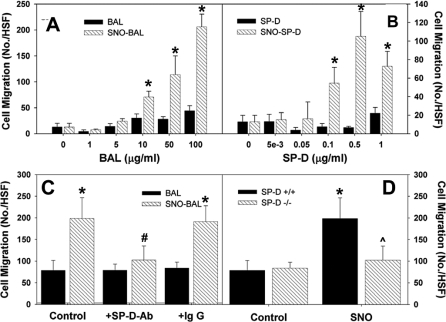
SNO-SP-D Induces Macrophage Chemotaxis(A and B) BAL and recombinant SP-D were assessed for their ability to induce RAW 264.7 macrophage migration using a modified Boydin chamber, following treatment with 200 μM SNOC or cysteine.(C) Using a BAL does of 100 μg/ml, cell migration was assayed subsequent to treatment with anti-SP-D or non-immune IgG.(D) SNOC treatment of BAL from SP-D
–/– mice did not induce macrophage chemotaxis. (asterisk represents significantly different from BAL; pound symbol represents significantly different from control or IgG; carat symbol represents significantly different from SNO SP-D
+/+; p < 0.05)